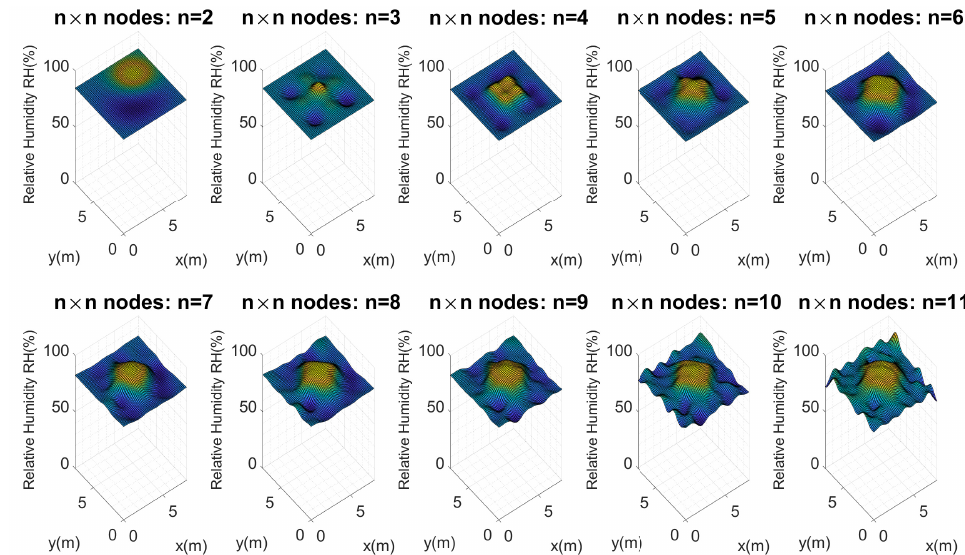
Figure 17. Soil moisture distribution maps in the test crop using n × n nodes. Third experimental